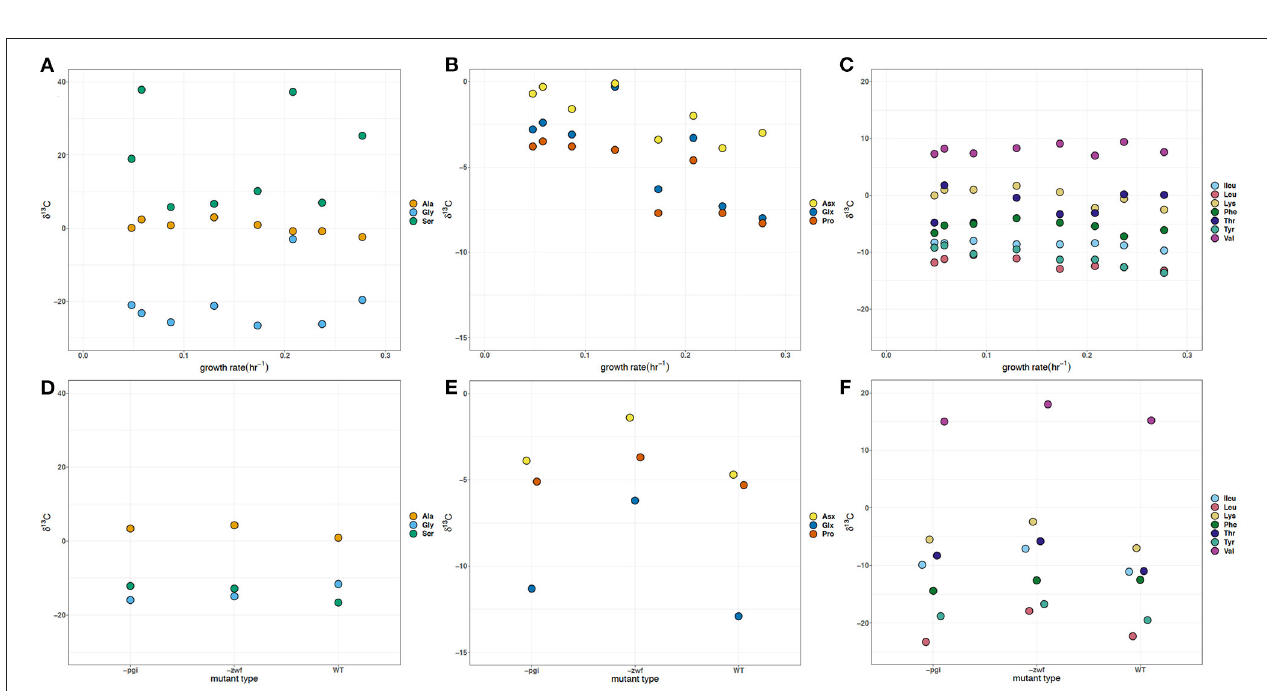
FIGURE 3 | δ 13 C of amino acids in Escherichia coli MG1655 chemostat cultures (A–C) and the WT strain along with mutant strains –pgi and –zwf in batch culture (D–F) . (A,D) The glycolytic amino acids: alanine (Ala), glycine (Gly), and serine (Ser). (B,E) The TCA cycle-dependent amino acids: aspartate + asparagine (Asx), glutamate + glutamine (Glx), and proline (Pro). (C,F) Branched amino acids: isoleucine (Ileu), leucine (Leu), lysine (Lys), threonine (Thr), and valine (Val) and aromatic amino acids: phenylalanine (Phe) and tyrosine (Tyr). The supplied glucose substrate had a δ 13 C of − 10.3 ‰ .